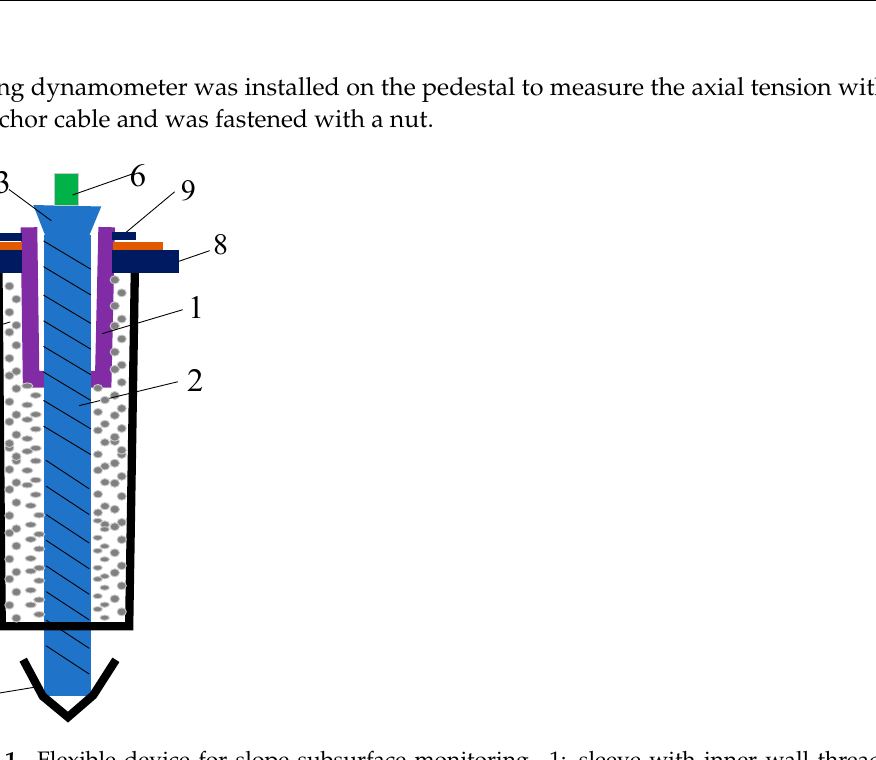
Figure 1. Flexible device for slope subsurface monitoring. 1: sleeve with inner wall threaded, 2: anchor cable, 3: conical metal head, 4: rubber tube, 5: backfill materials, 6: acoustic emission transducer, 7: ring dynamometer, 8: pedestal, 9: nut, 10: anchoring end.